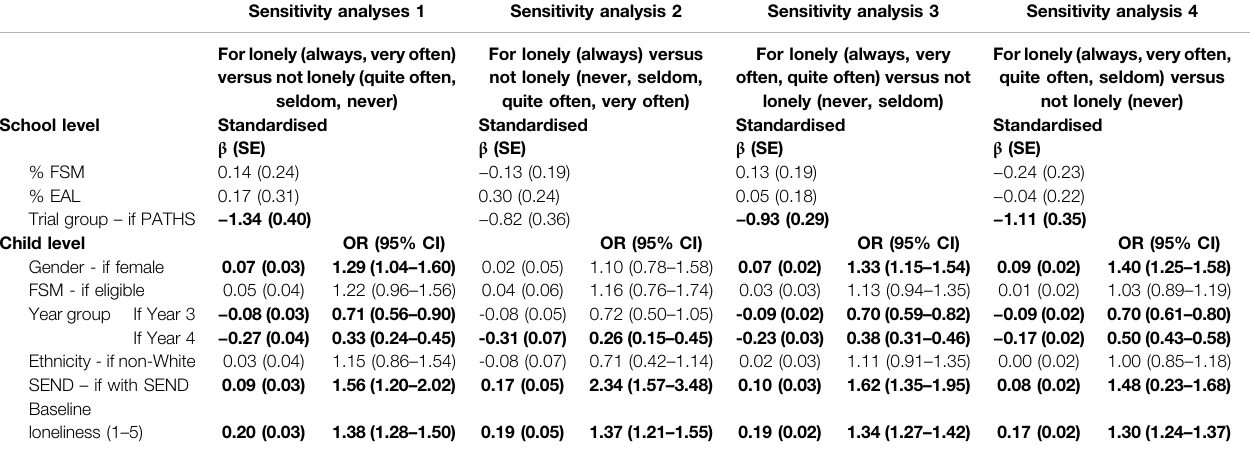
TABLE 4 | Sensitivity analysis hierarchical logistic regression models of the impact of PATHS curriculum on loneliness. Sensitivity analyses 1 Sensitivity analysis 2 Sensitivity analysis 3 Sensitivity analysis